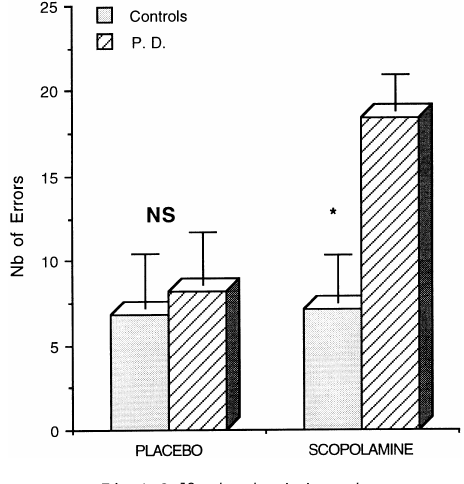
Fig. 4. Self ordered pointing task.